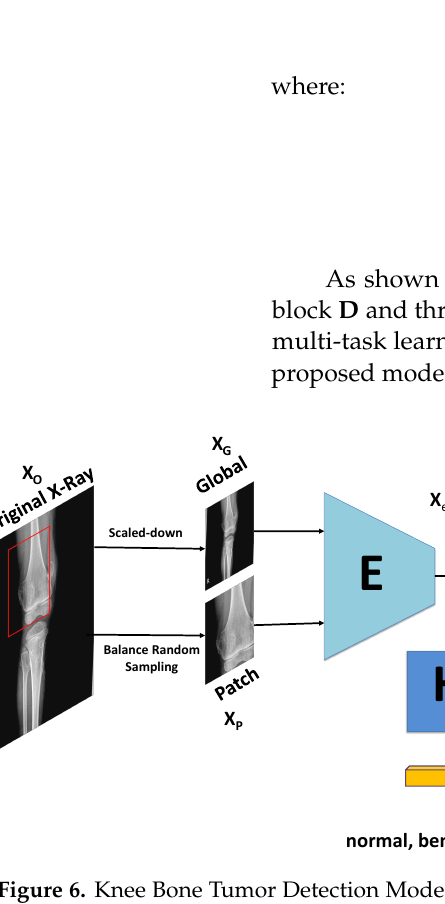
Figure 6. Knee Bone Tumor Detection Model. It uses the geometric-context classification H clas to enhance the encoding feature X enc from encoding E to return the geometric-context probability vector Y clas . The 2D decoding feature map is enhanced by multi-task learning at the pixel level between the pixel-tumor segmentation H seg and the high-risk pixel-tumor segmentation H dis for outputting tumor segmentation mask ˆ Y seg and multi-level distance features ˆ Y dist . ˆ Y dist has the role of high-risk attention around tumor regions. The model’s input is from the scaled-down image X G of the original X-ray image X for the global model and the patch image XP generated from balance random sampling for the patch